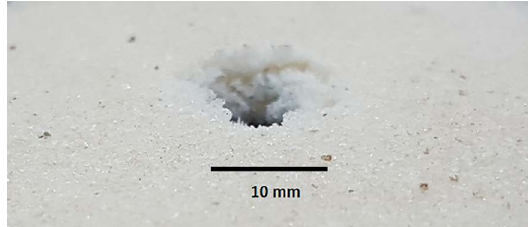
Figure 7. Optical image showing the conical damage zone on the distal face of an A80/50